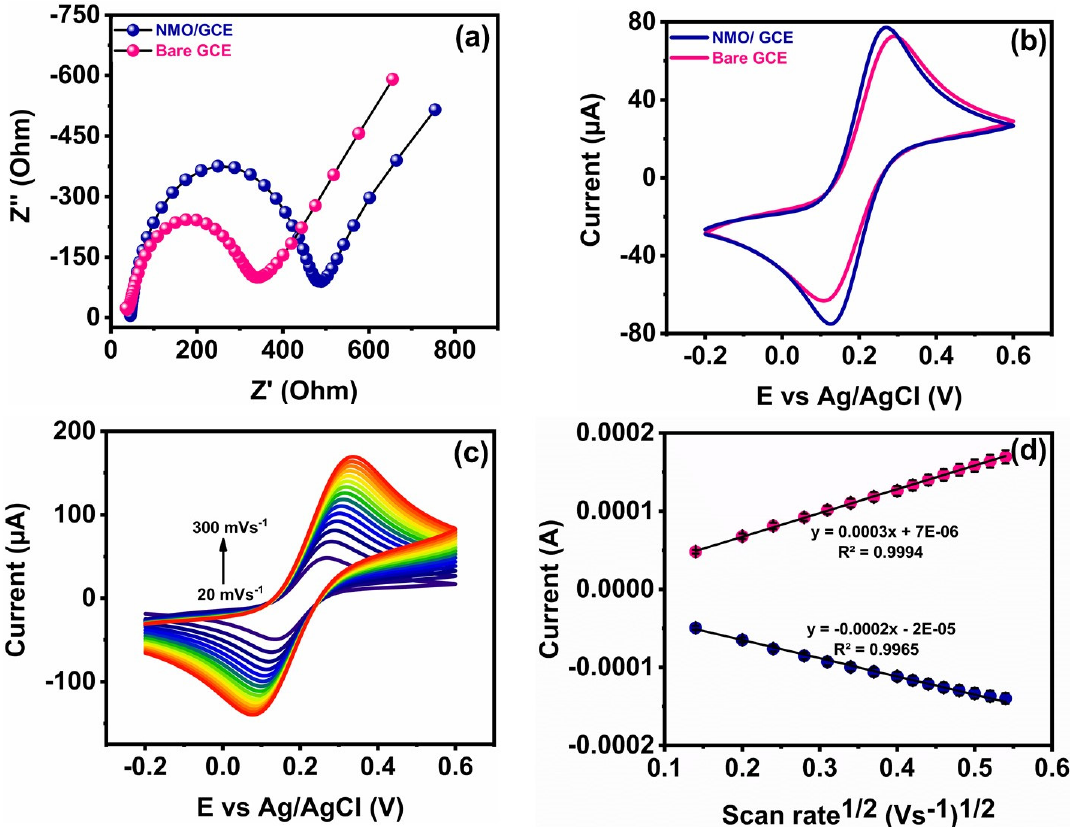
Figure 5. ( a ) EIS spectra of bare GCE and NMO/GCE, ( b ) CV redox current response of bare GCE and NMO/GCE at a scan rate of 50 mVs − 1 , ( c ) CV response of NMO/GCE at a different scan rate of 20–200 mVs − 1 , ( d ) the corresponding linear plot for the redox current response and the square root of the scan rate. All experiments were performed in 5 mM [Fe (CN) 6 ] 3-/4- with 0.1 M KCl solution. The CV technique was used to examine the catalytic activity of NMO/GCE in a fer- ric/ferrous system containing 0.1 M KCl solution at a scan rate of 50 mVs − 1 shown in Figure 5(b). The NMO/GCE had a higher redox peak current compared to bare GCE. The excel- lent electrocatalytic activity of NMO/GCE is due to the large surface area and increased number of active sites. The peak-to-peak separation value of bare GCE and NMO/GCE was 0.147 and 0.184 mV, respectively. The highest redox peak current and low peak-to- peak separation of NMO/GCE are due to the NMO rod structure, large surface area, and more active sites; therefore, NMO/GCE is exposed to quick electron transfer in a Ferri/Ferro system. The electroactive surface area of bare GCE and NMO/GCE was calculated by differ- ent scan rate investigations by CV analysis. Figure 5c shows the CV redox current of NMO/GCE at various scan rates of 20–300 mVs − 1 in a [Fe (CN) 6 ] 3 − /4 − system containing 0.1 M KCl solution. With increasing scan rate, the redox peak current increased, which reveals the fast kinetics of NMO/GCE. Figure 5d displays the linear plot of the redox current vs. square root of the scan rate and a linear regression equation with co-efficient value for anodic and cathodic I pa = 0.0003x + 7 × 10 − 6 , R 2 = 0.9994 and I pc = − 0.0002x − 2 × 10 − 5 , R 2 = 0.9965, respectively. The Randles–Sevcik equation was used to calculate the electroactive surface area of NMO/GCE, I pa = (2.69 × 10 5 ) n 3/2 ACD 1/2 v 1/2 (1) where I pa is peak current value, n is number of electrons involved in the electrochemical reaction, Dis the diffusion coefficient, v is scan rate, and C is concentration of the Ferro